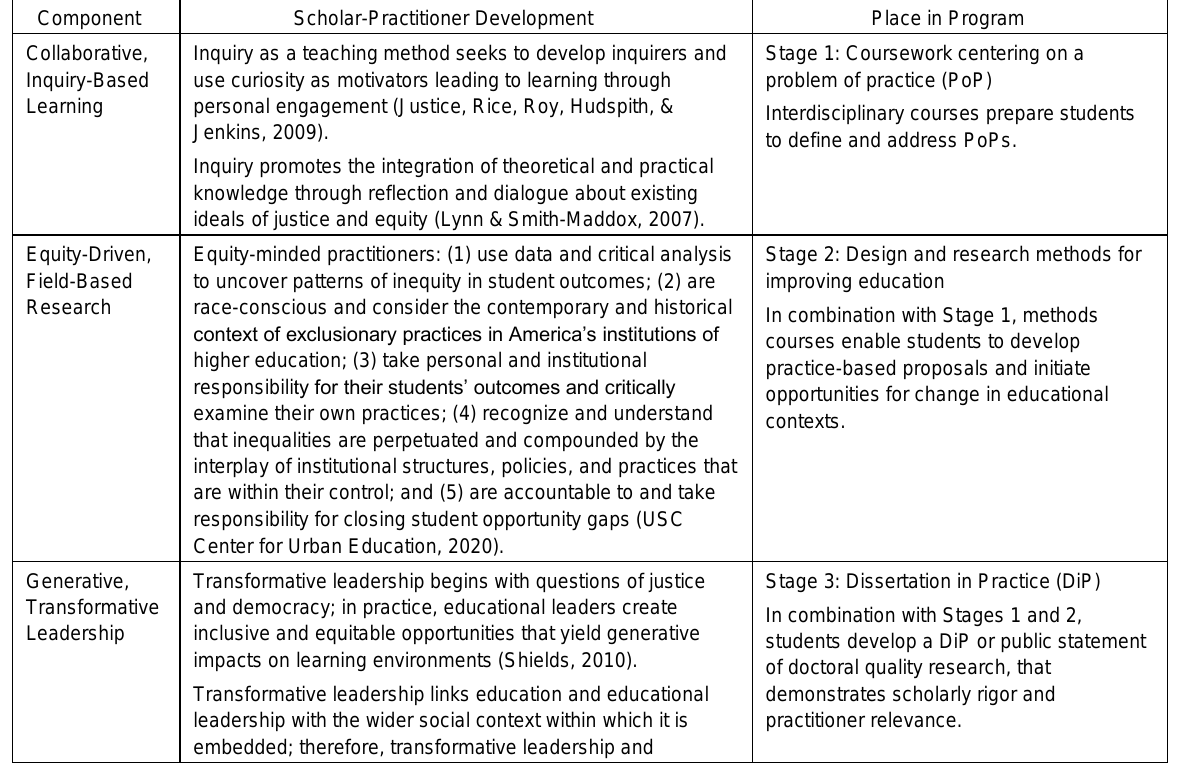
Table 1. Three-Component Signature Pedagogy